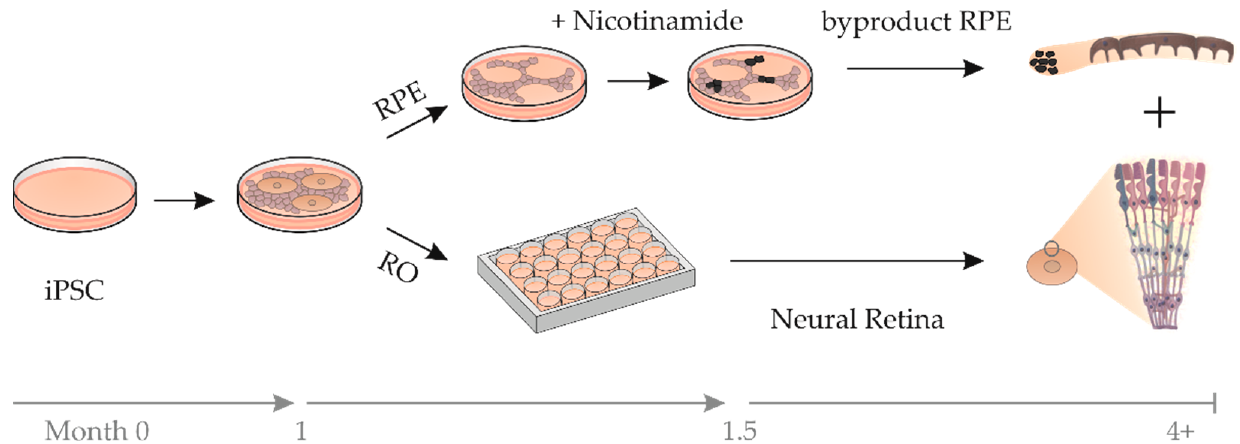
Figure 2. Schematic representation of the simultaneous differentiation of byproduct RPE (bRPE) and retinal organoids (ROs). Induced pluripotent stem cells (iPSCs) were differentiated to ROs and bRPE simultaneously. After 1 month, the ROs were excised and transferred to 24-well plates for further cultivation. The remaining cells were treated with nicotinamide, and after 1.5 months pigmented cell clusters (representing bRPE) were excised and expanded.